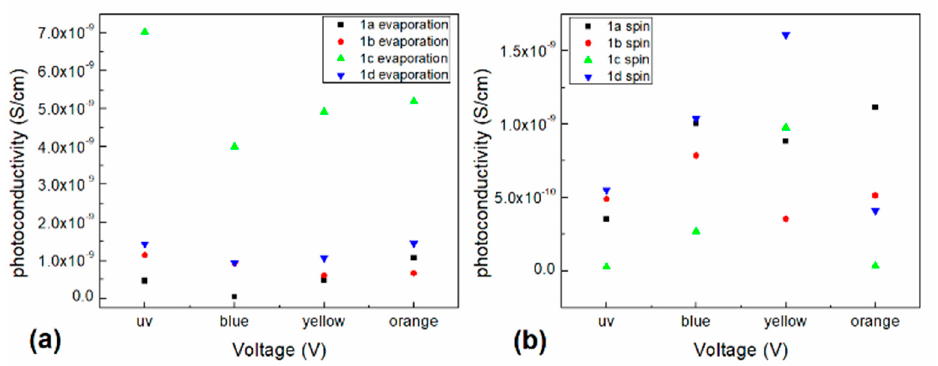
Figure 9. Incident light dependent photoconductivity for the ( a ) evaporated and ( b ) spin-coated organotin (IV) complexes devices.